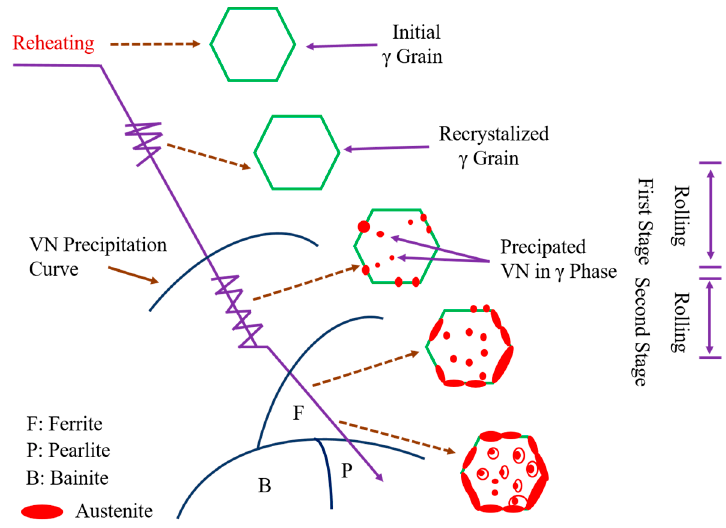
Figure 3. Characteristics of HTUFE [27].